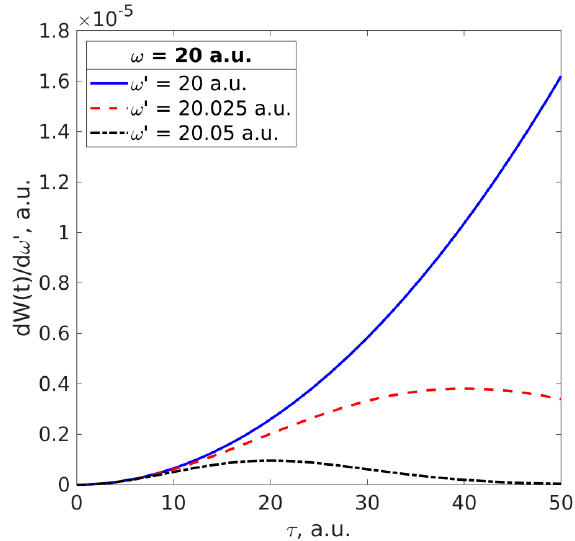
Figure 4. The spectral scattering probability dependence on the pulse duration in the long-time limit for di ff erent scattering frequencies.